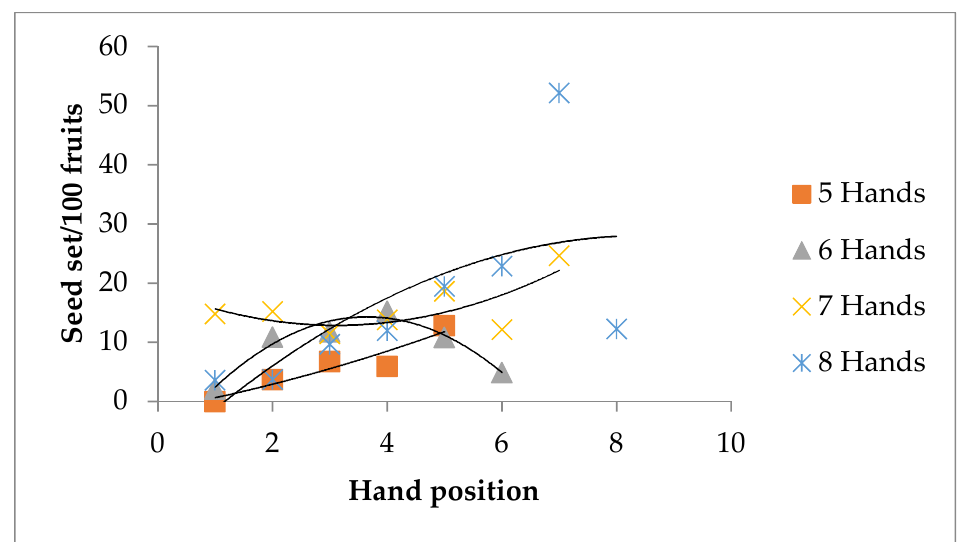
Figure 4. Seed set per 100 fruit per hand in different sized bunches of “Nshonowa”. Table 3. Second order polynomial and R 2 values fitted for seed set per 100 fruits per hand.